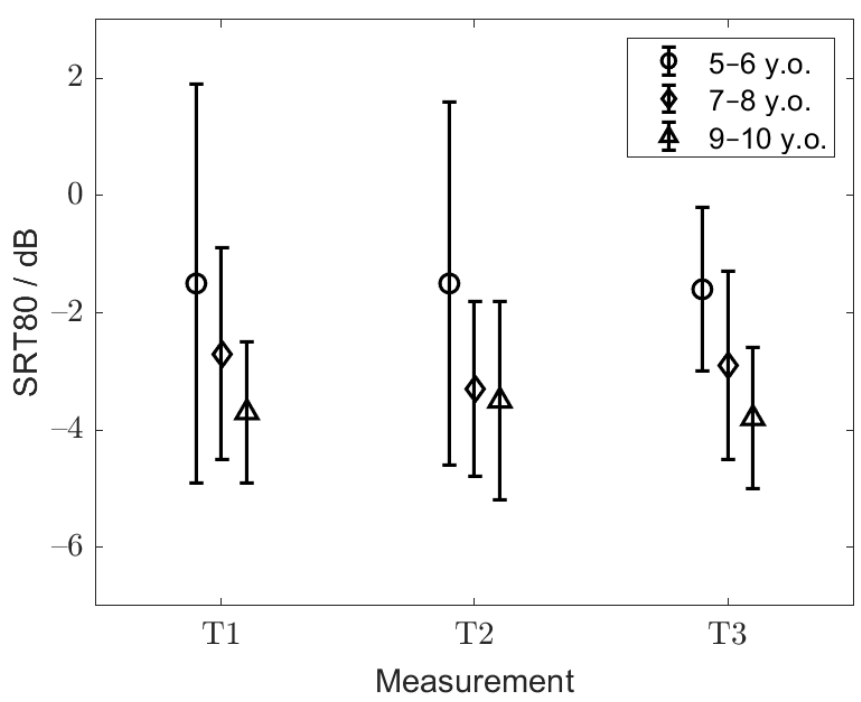
Figure 4. Mean SRT80 with corresponding standard deviation for the respective training list (T1–3) and age group.